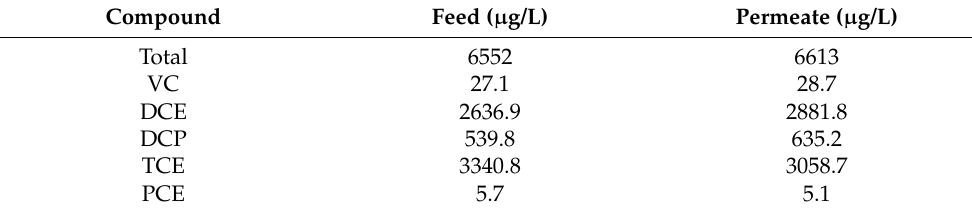
Table 10. GC–MS data for five main components detected on 21th July.